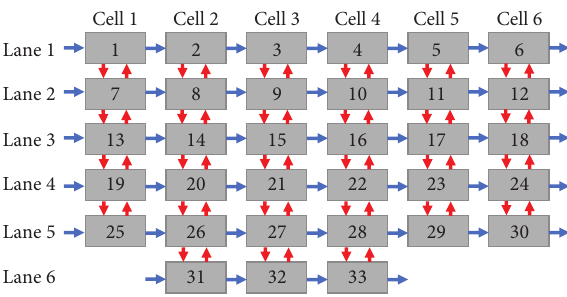
Figure 14: Lane and cell position for US-101 highway.